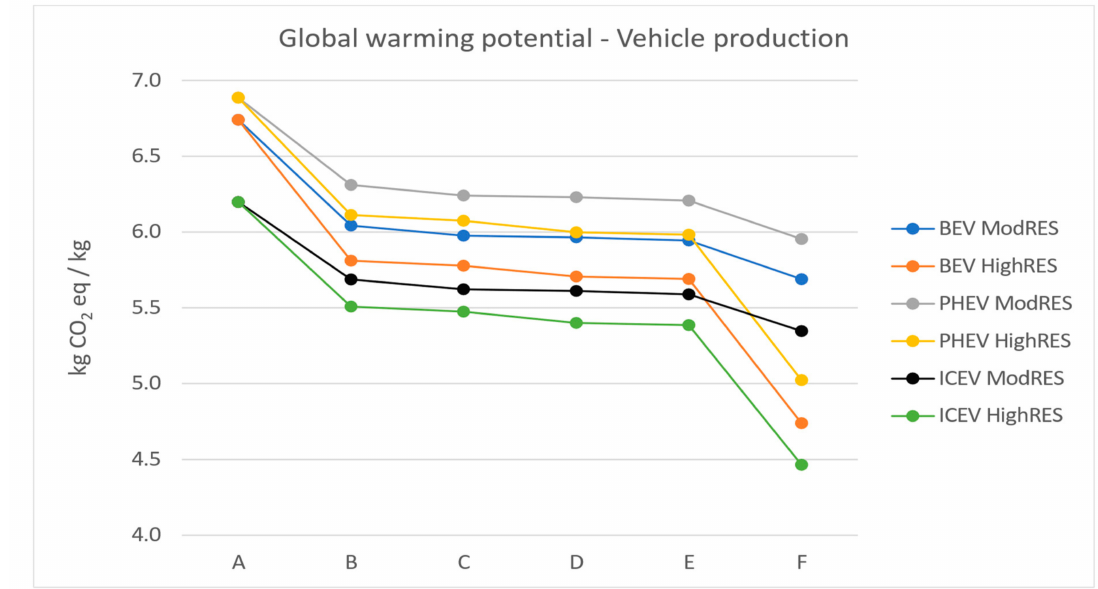
Figure 6. Potential GWP of producing 1 kg of BEV, P-HEV and ICEV considering expected future developments in steel and energy production. For ModRES and HighRES, results are presented cumulatively, where A refers to the reference case, B refers to improvement due to scenario-based electricity mix for vehicle manufacture, C refers to changes in B plus e ffi ciency improvement in electricity demand for vehicle manufacture, D refers to changes in C plus changes in heat mix in vehicle manufacture, E refers to changes in D plus e ffi ciency improvement in heat demand for vehicle manufacture, and F refers to changes in E plus scenario-based